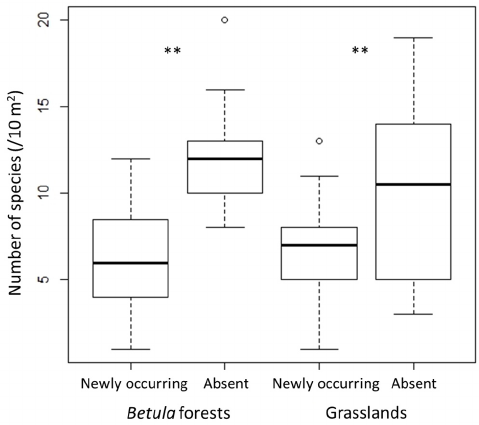
Figure 2. Numbers of newly occurring and absent species in each vegetation type. The exact Wilcoxon signed-rank test was used to compare between the number of those species. ** p < 0.01. The changes of β -diversity among transects in each vegetation type from 2010 to 2018 differed between metrics of incidence and abundance (Figure 3). Among the incidence metrics, β SOR (Sørensen dissimilarity) and β SIM (Simpson dissimilarity) decreased significantly, and β SNE (nestedness-driven dissimilarity) increased significantly from 2010 to 2018 in the Betula forests. Among the abundance metrics, β BC (Bray–Curtis dissimilarity) and β BC.BAL (substitution) increased significantly, and β BC.GRA (subset) decreased from 2010 to 2018 in the grasslands. The β -diversity among transects did not change significantly between vegetation types based on either incidence or abundance metrics (Figure S2). The metrics associated with species replacement ( β SIM for incidence data and β BC.BAL for abundance data) made a greater contribution to total β -diversity than those associated with nestedness ( β SNE for incidence data and β BC.GRA for abundance data) (Figures 3 and S2).